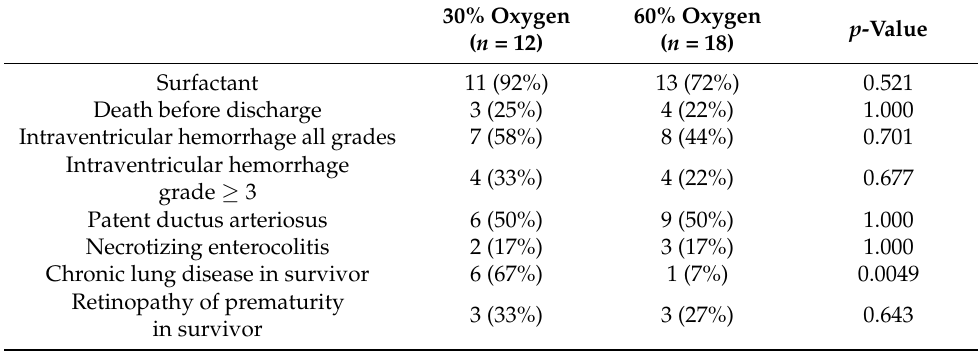
Table 1. Demographics of study infants. Table 2. Secondary neonatal